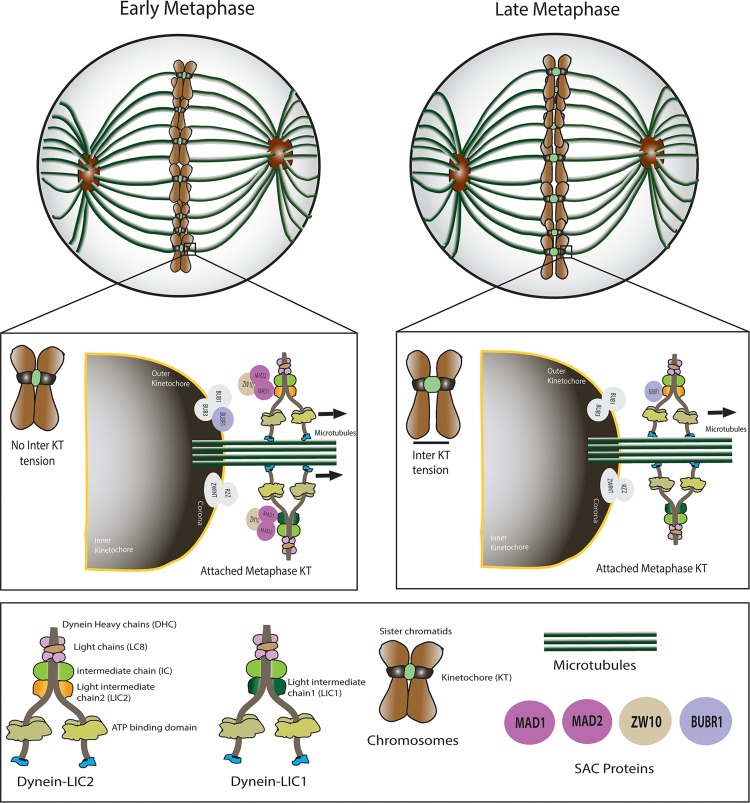
A model for key LIC2 functions in SAC silencing during mitosis.Novel functions of mitotic LIC2 uncovered from this study in silencing the spindle assembly checkpoint (SAC) are shown. LIC2-dynein strips attachment sensing SAC proteins (Mad1, Mad2, Zw10) from metaphase kinetochores, like LIC1-dynein. LIC2-dynein has the additional capability of causing removal of tension-sensing SAC protein BubR1, which is lacking in LIC1-dynein. The model offers a possible mechanistic explanation for the differential effects of the two LICs in mediating metaphase to anaphase progression.